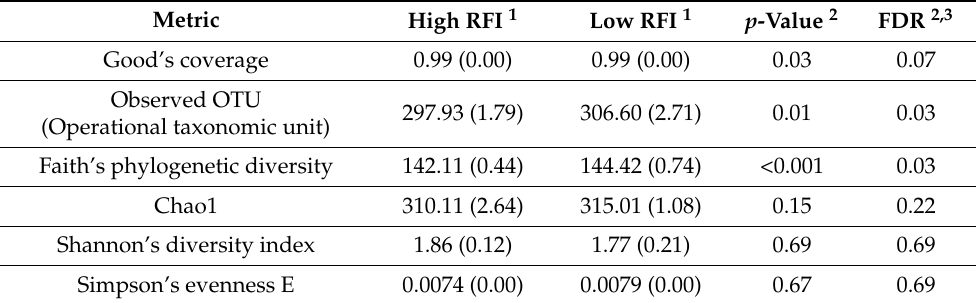
Table 1. Alpha-diversity metrics between high- and low-residual feed intake (RFI)